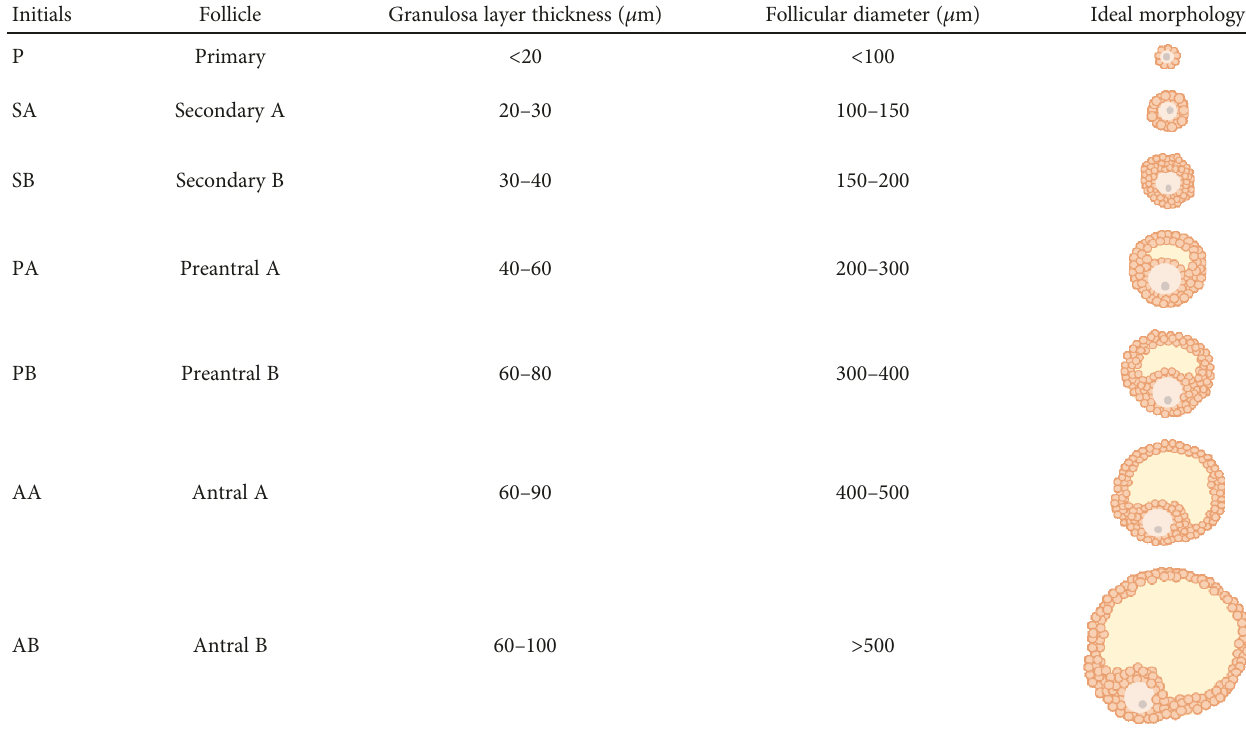
Table 1: Classi fi cation of follicles in the base of morphological